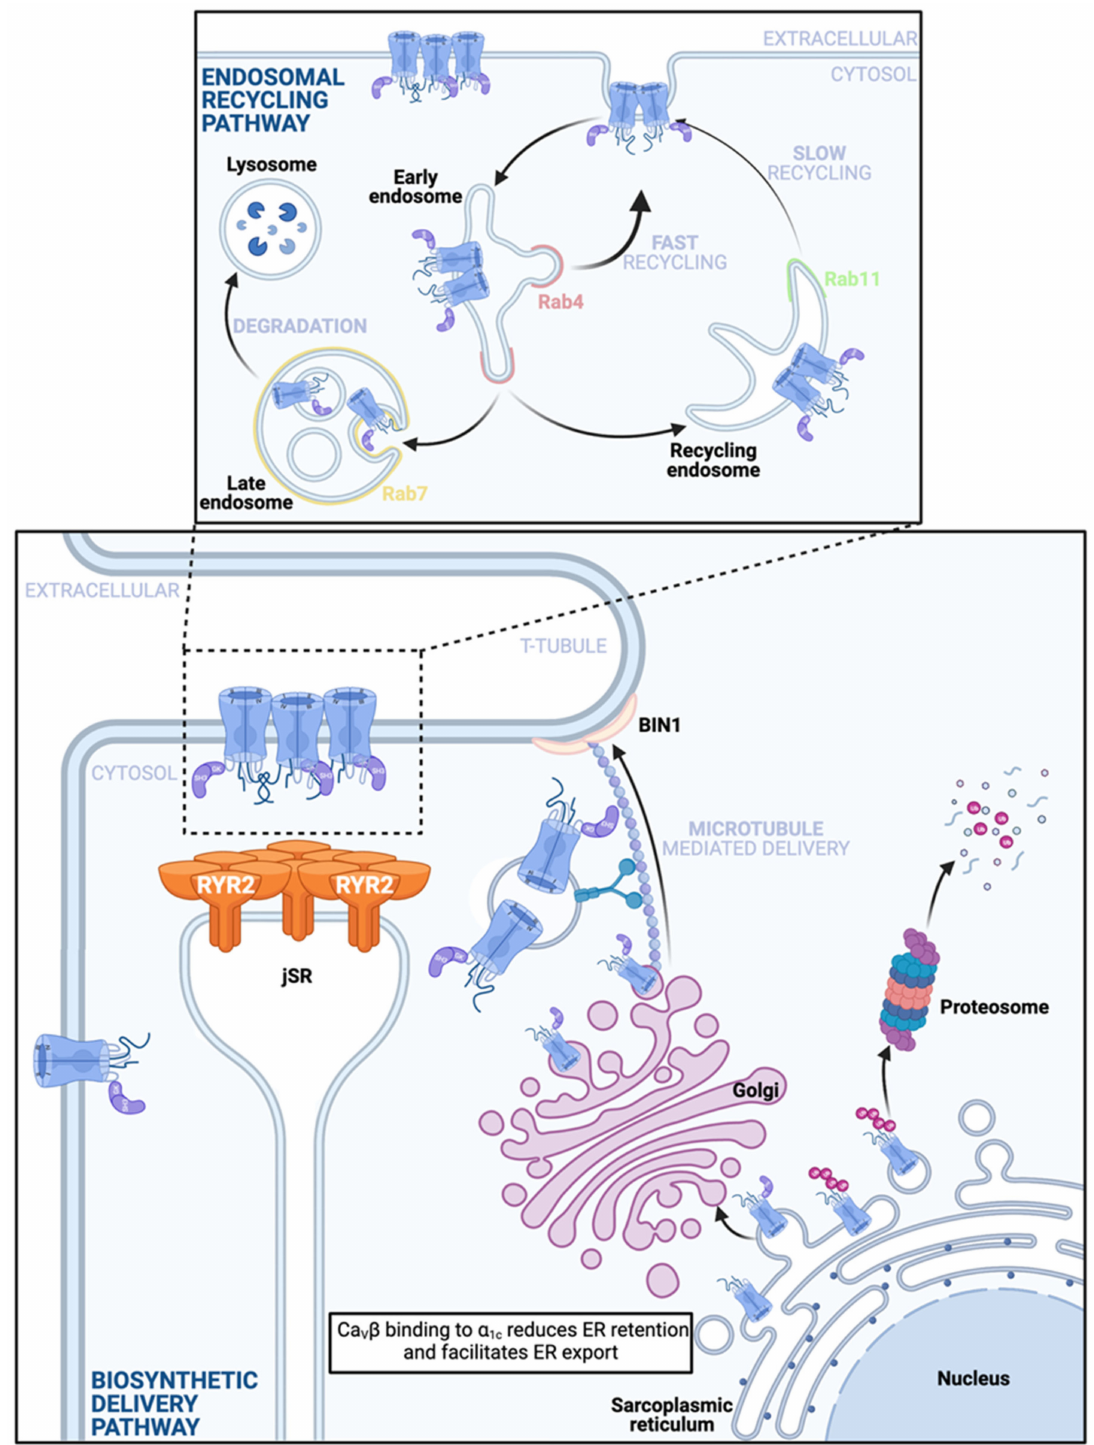
Figure 2. Anterograde Ca V 1.2 channel delivery pathways. Bottom: A depiction of the ‘Biosynthetic Delivery Pathway’ that commences when Ca V α 1c are translated directly into the rER membrane. These pore-forming subunits have several ER retention motifs and just one identified ER export motif. Binding of the Ca V β subunit to the Ca V α 1c while in the ER membrane is